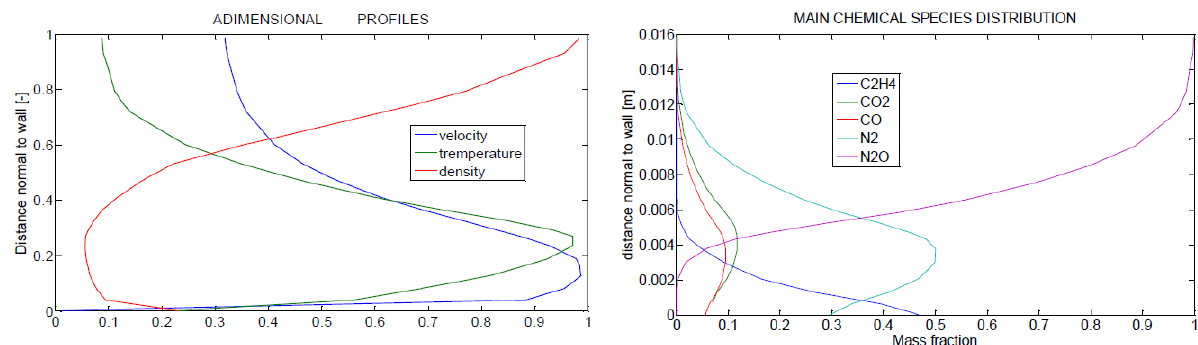
Figure 13. Images from [92] clearly showing stratification and poor mixing for a different injection pattern.